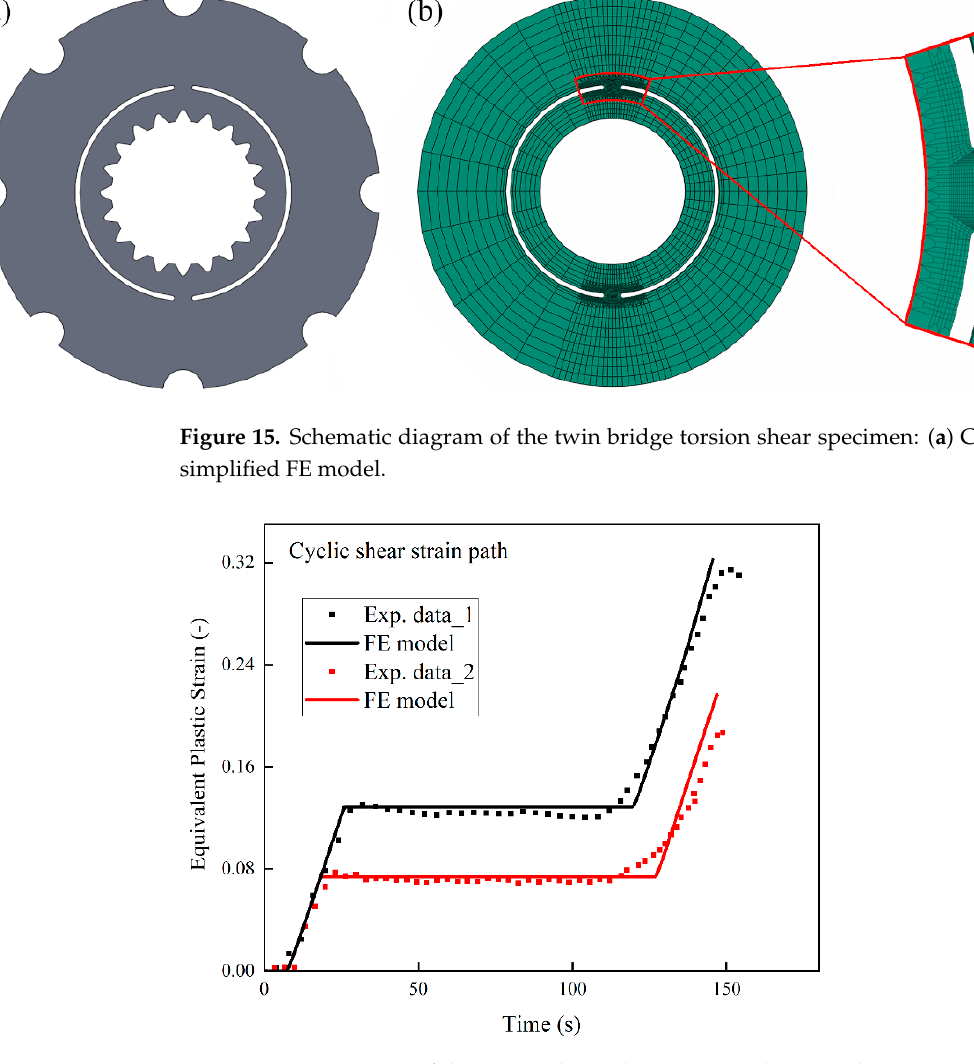
Figure 16. Comparison of the EPS evolution between simulation and experiment: these include the evolution of the EPS on the surface of the twin bridge torsion shear specimen for two experimental protocols and the evolution of the equivalent plastic strain on the surface extracted in the FE model.